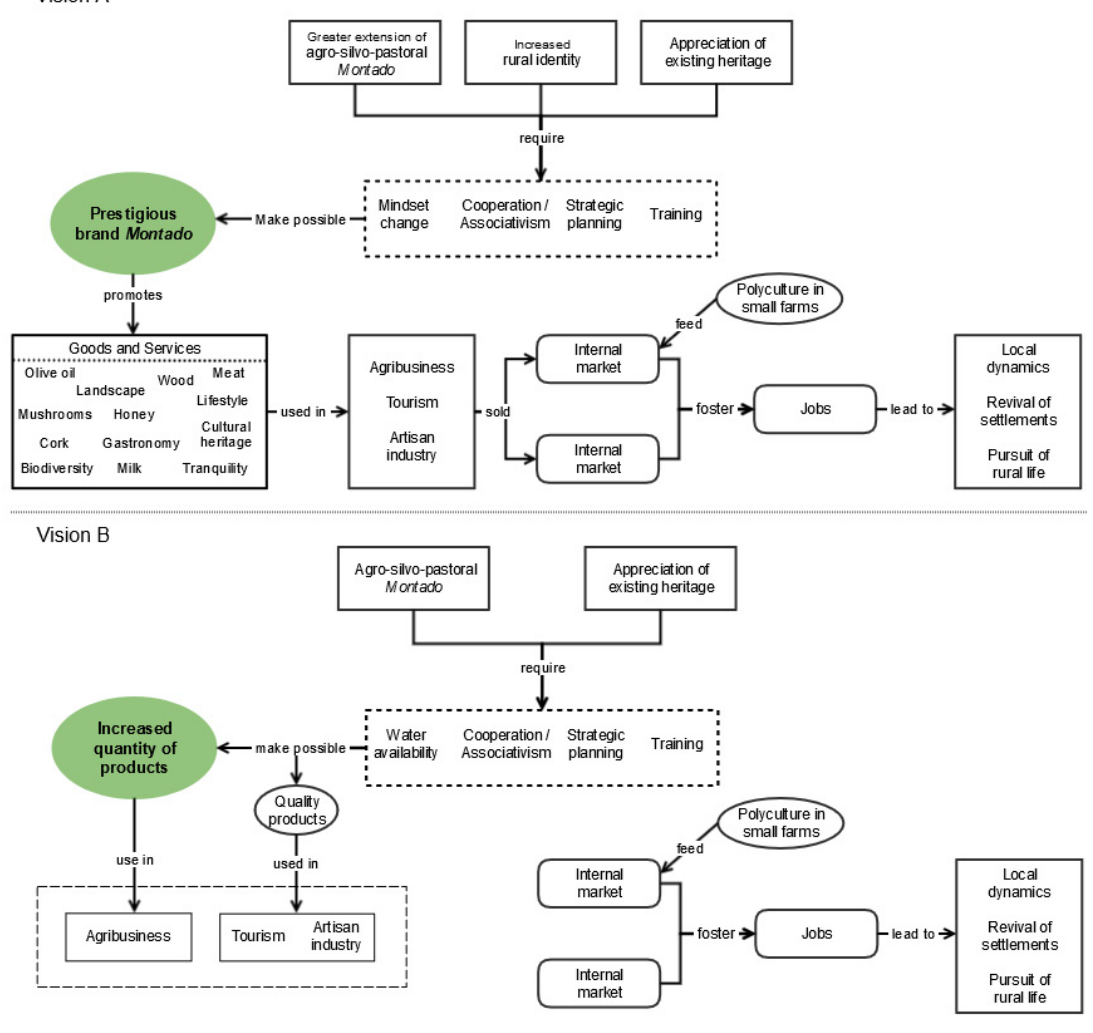
Figure 4: The visions produced in 2013 by a transdisciplinary team during the FarmPath project. In vision A, the Montado is thought of as the main driver of rural development, whereas in vision B, the intensification of production and irrigation are also considered in addition to the Montado system. (Source: this